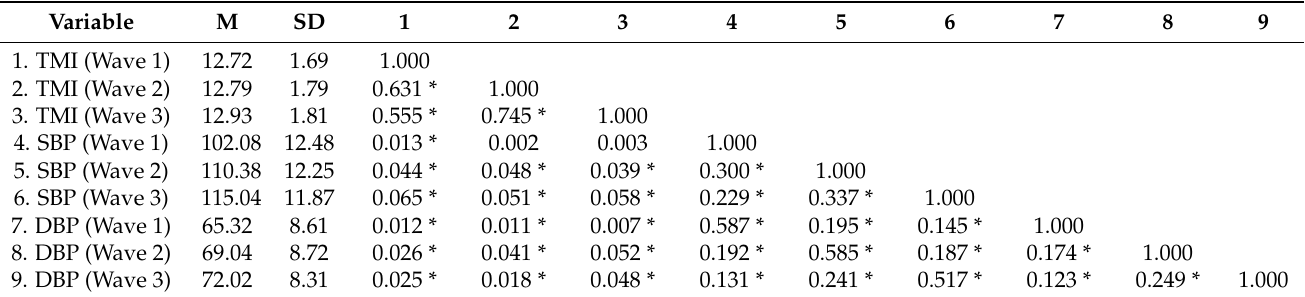
Table 2. Bivariate correlations between TMI and blood